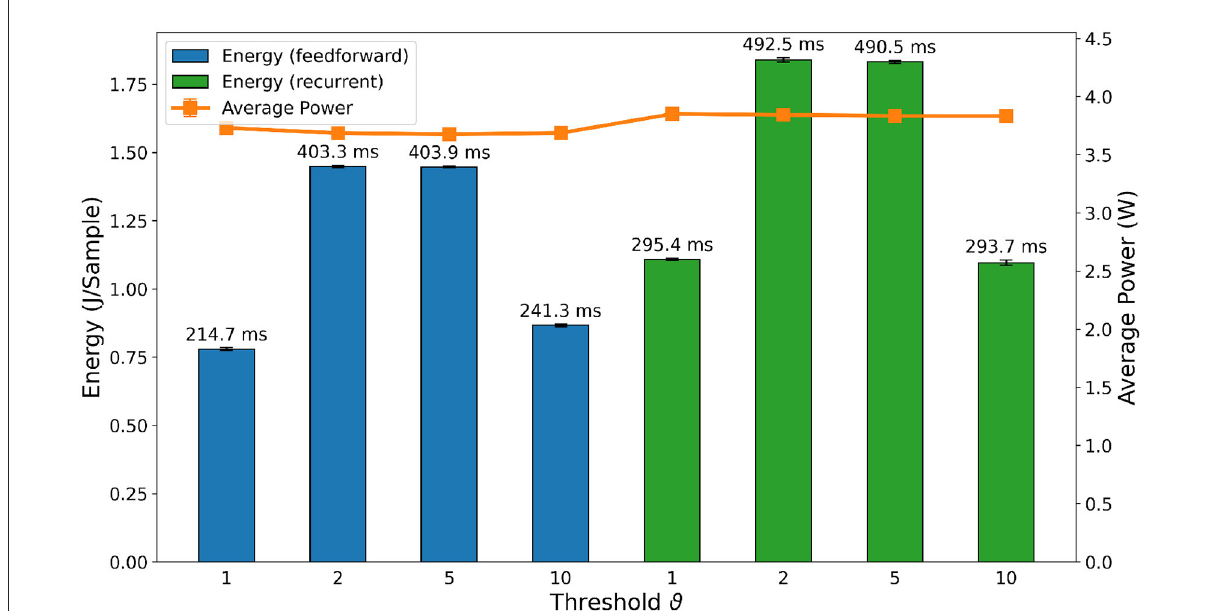
FIGURE9 Comparison of inference metrics for all spiking neural networks in terms of energy consumption and average power usage as measured on an NVIDIA Jetson Xavier NX. The label on top of each bar shows the inference time per sample on the corresponding network.